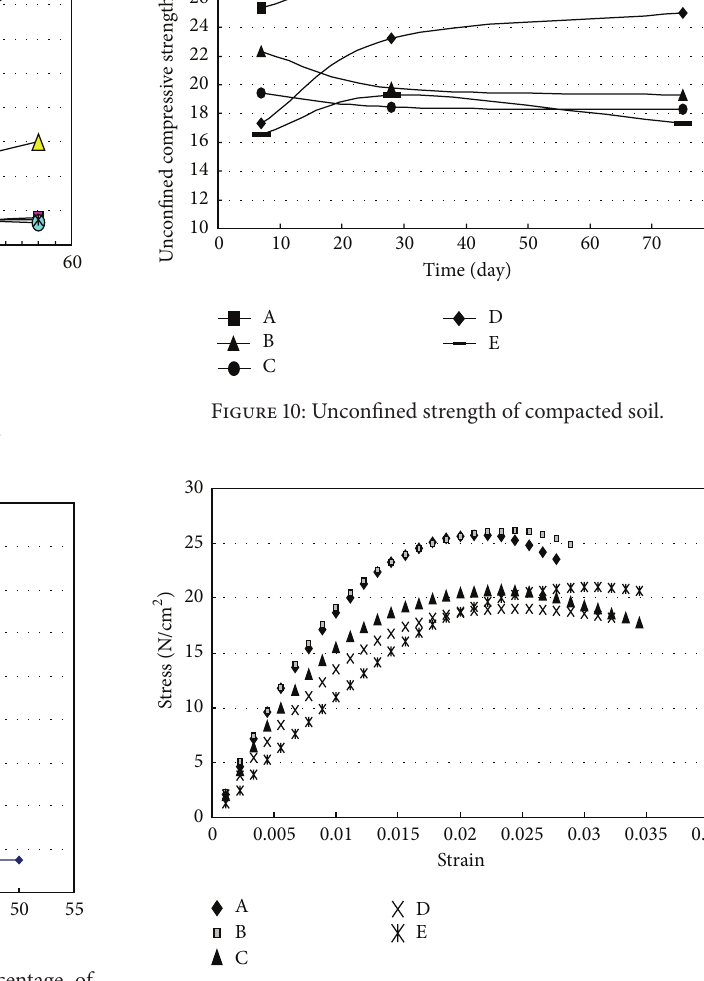
Figure 11: Stress and strain of the compacted soil at 7